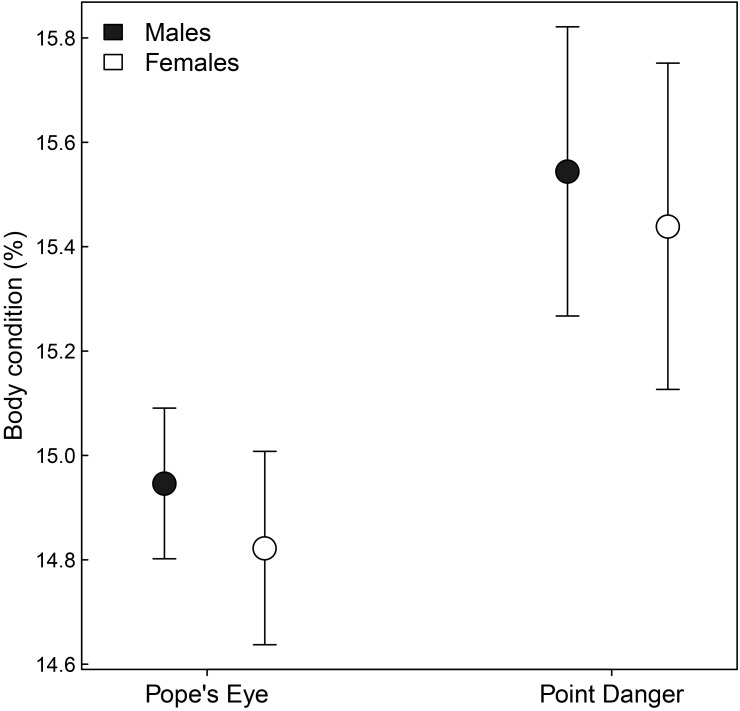
Mean body condition (%) ± SE for males and females from Pope’s Eye and Point Danger gannet colonies.Where males are in black and females are in white.